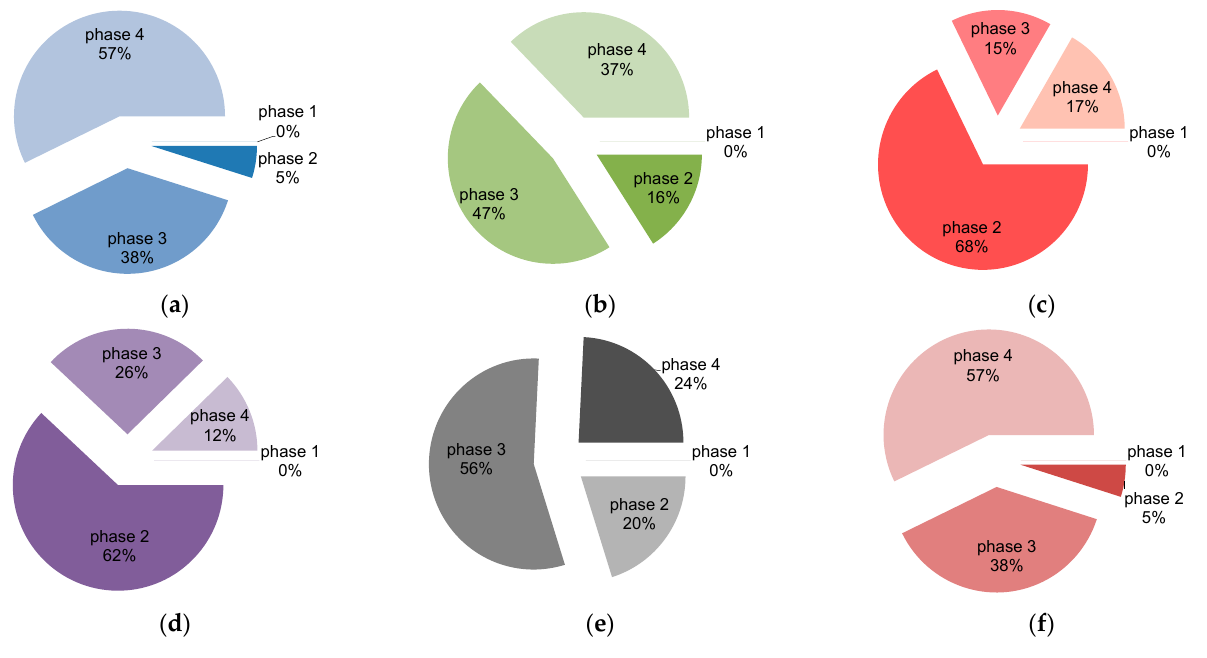
Figure 25. Contributions of each test phase to total on-road emissions and mileage fuel consumption in the WLTC test during plug-in vehicle testing: ( a ) carbon dioxide, ( b ) carbon monoxide, ( c ) nitro-